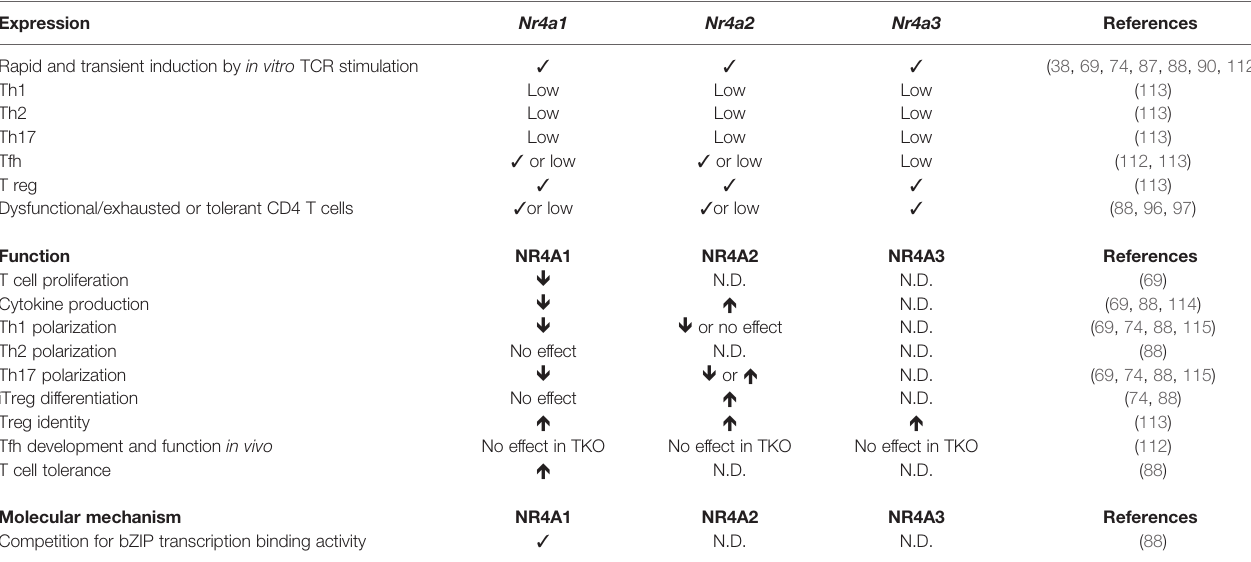
TABLE 2 | Role of NR4A family members in CD4 T